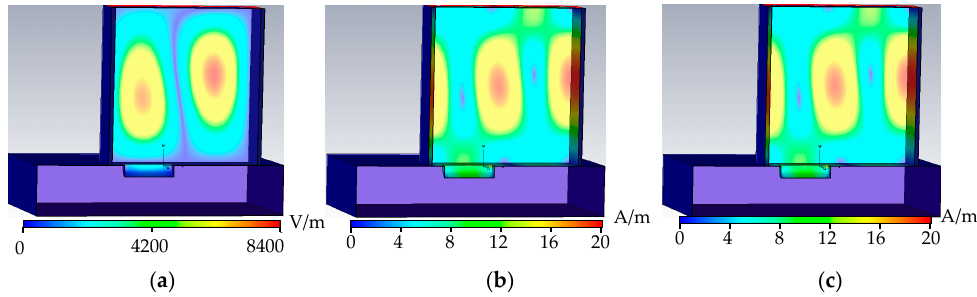
Figure 10. Semi ‐ cylindrical defect field distribution. ( a ) Semi ‐ cylindrical defect electric field distribution. ( b ) Semi ‐ cylindrical defect magnetic field distribution. ( c ) Semi ‐ cylindrical defect wall current distribution.